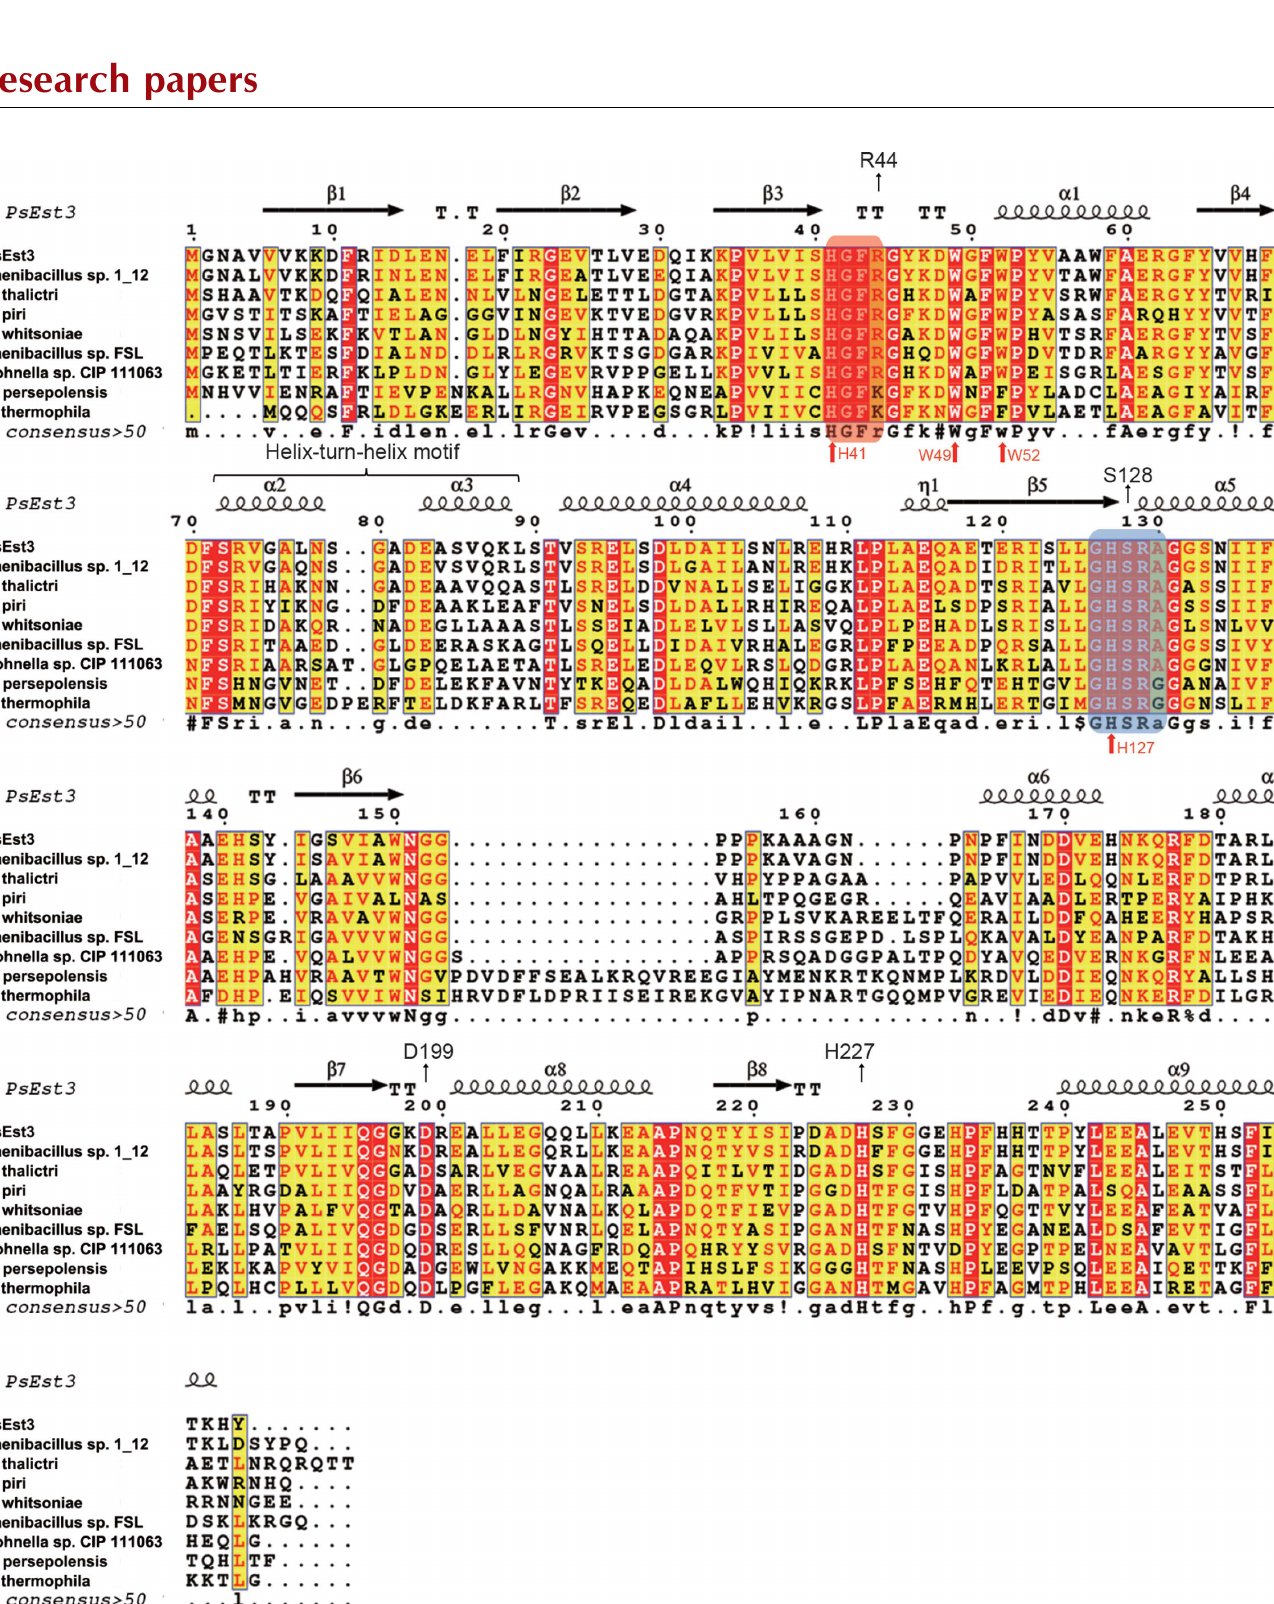
Figure 3 Multiple sequence alignment of PsEst3 with eight homologs [ Paenibacillus sp. 1_12 (UniProt accession No. A0A1I4E7Z0), P. thalictri (A0A4Q9DLG8), P. piri (A0A4R5KT22), P. whitsoniae (A0A430JH40), Paenibacillus sp. FSL H7-0357 (A0A089I8J6), Cohnella sp. CIP 111063 (A0A231R2L3), Alteribacillus persepolensis (A0A1G8AGB0) and Lihuaxuella thermophila (A0A1H8C781)] obtained from the BLAST results of PsEst3 using the UniProt database. The last two homologs (A0A1G8E3W4 and A0A1H8C781) that contain a GHSRG motif instead of GHSRA were added to the alignment. The secondary structure of PsEst3 is shown above the sequence. The pentapeptide sequence (GHSRA/G) and oxyanion hole-forming sequence (HGFR/K) are highlighted with blue and red rectangles, respectively. The catalytic triads and residues forming the acyl-binding pocket are indicated with black and red arrows, Jonghyeon Son et al. (cid:5) PsEst3